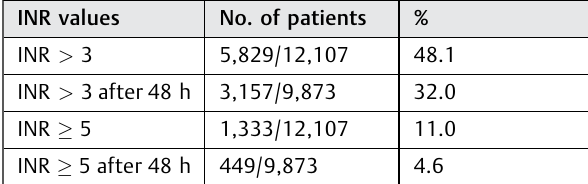
Table 2 Supratherapeutic INRs INR values